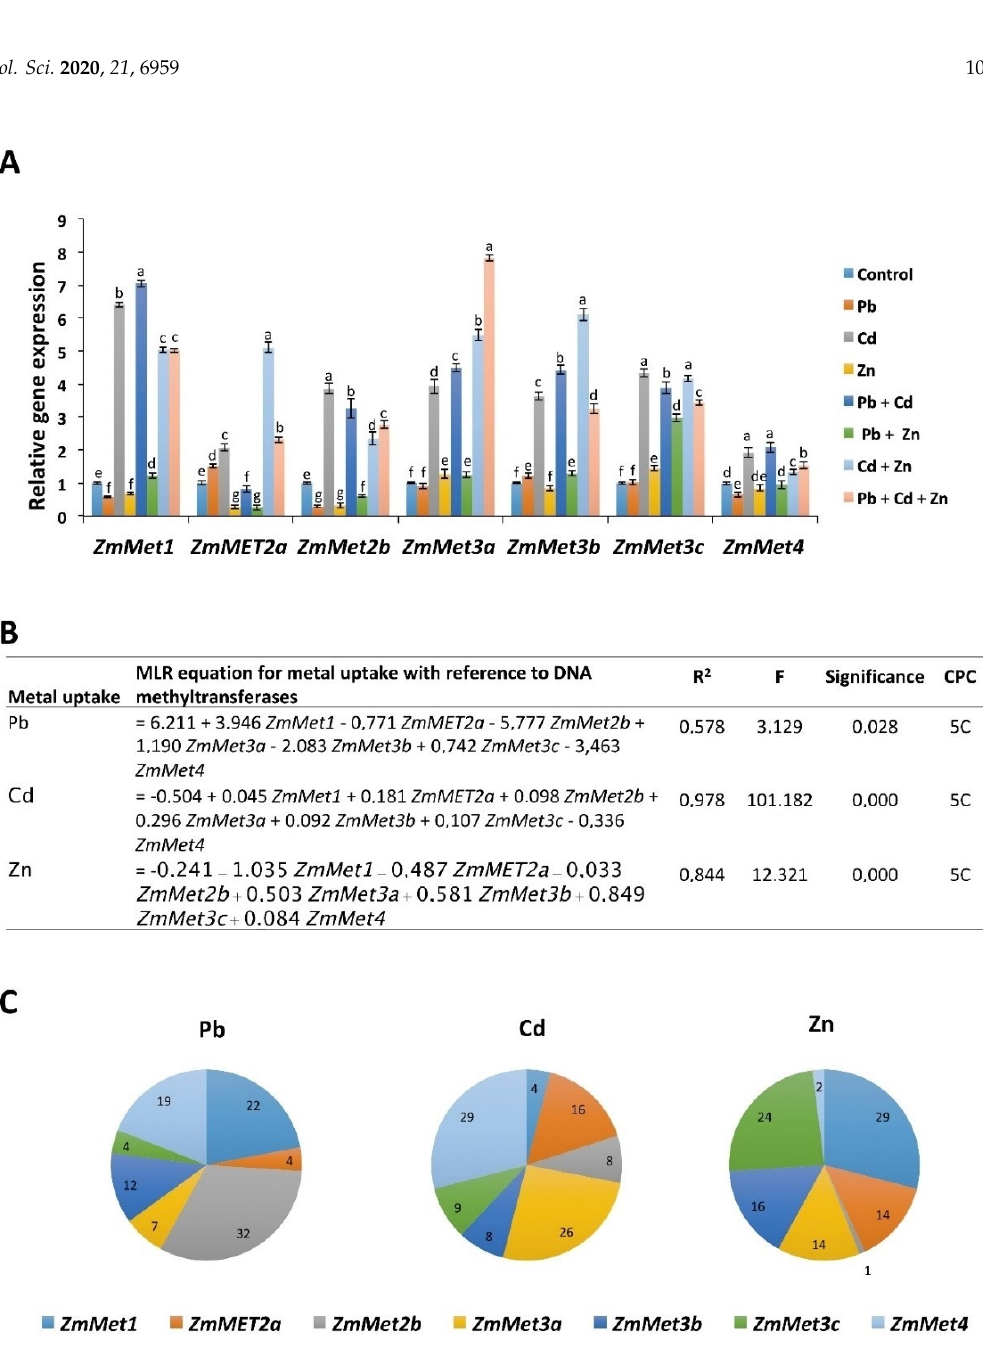
Figure 5. The expression of DNA methyltransferases in response to Pb/Cd/Zn applied alone and in combinations. (A) The expression of DNA methyltransferases was normalized with ZmUBQ5 . The data presented are the averages of three biological replicates. Bars represent mean ± SD. The values marked with different letters are statistically different ( p ≤ 0.05), while the values marked with the same letters do not differ significantly. ( B ) Multiple linear regression (MLR) equations for uptake of each heavy metal and expression of DNA methyltransferases. ( C ) Cumulative percentage contribution (CPC) for expression of each DNA methyltransferase in response to the uptake of heavy metals.